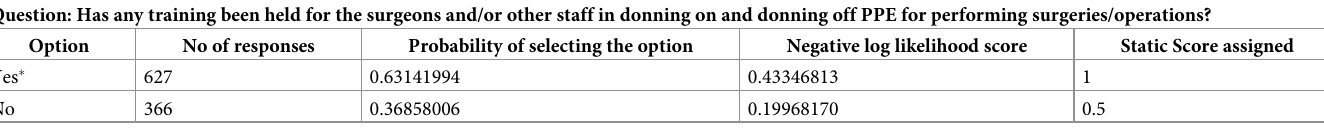
Table 2. Illustration of calculation of weighted negative log likelihood score for options used in the present study. Question: Has any training been held for the surgeons and/or other staff in donning on and donning off PPE for performing